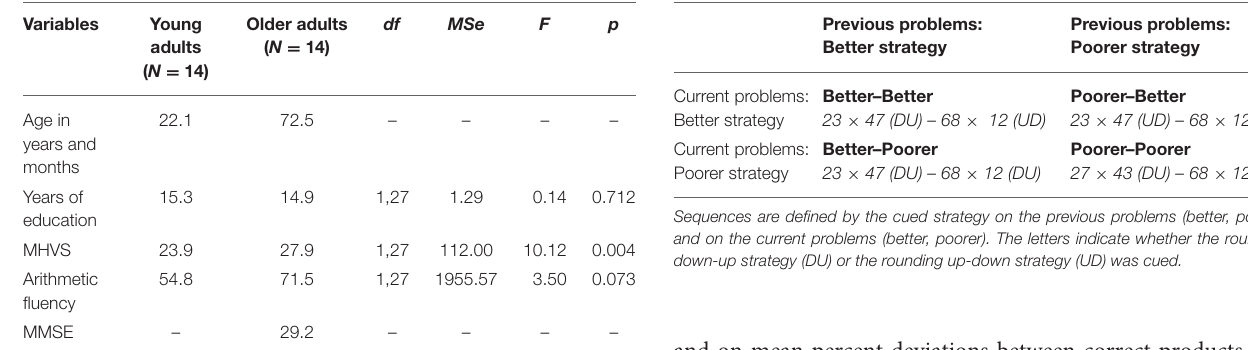
TABLE 1 | Participants’ characteristics. TABLE 2 | Four types of sequences tested in this